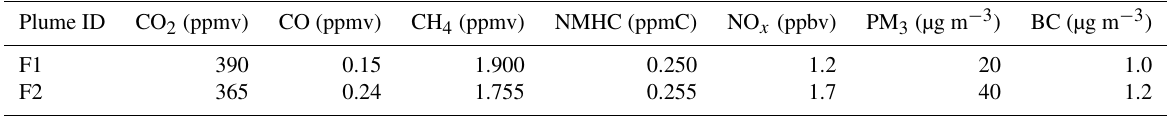
Table 3. Background levels of trace gases and aerosols outside the F1 and F2 plumes. Plume